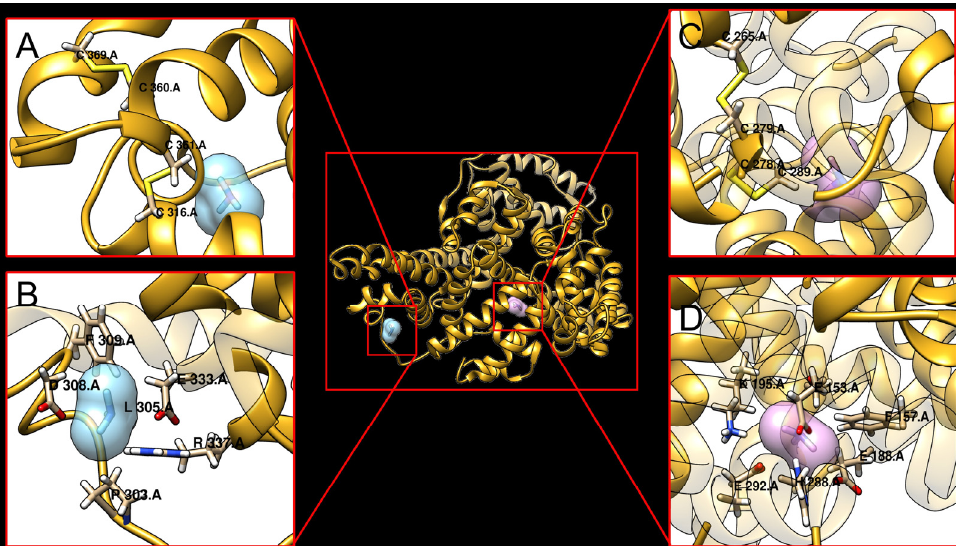
Figure 2. Left : HAS in complex with TMA’s lowest energy cluster (blue transparent VdW surface) ( A ) focusing on S–S bonds involved in the interaction site; ( B ) a focus on the specific TMA interaction at its corresponding binding cleft. Right : HAS in complex with the second TMA energy cluster (violet transparent VdW surface); ( C ) S–S bonds involved are highlighted; ( D ) a focus on TMA’s second cluster interaction at its binding cleft.